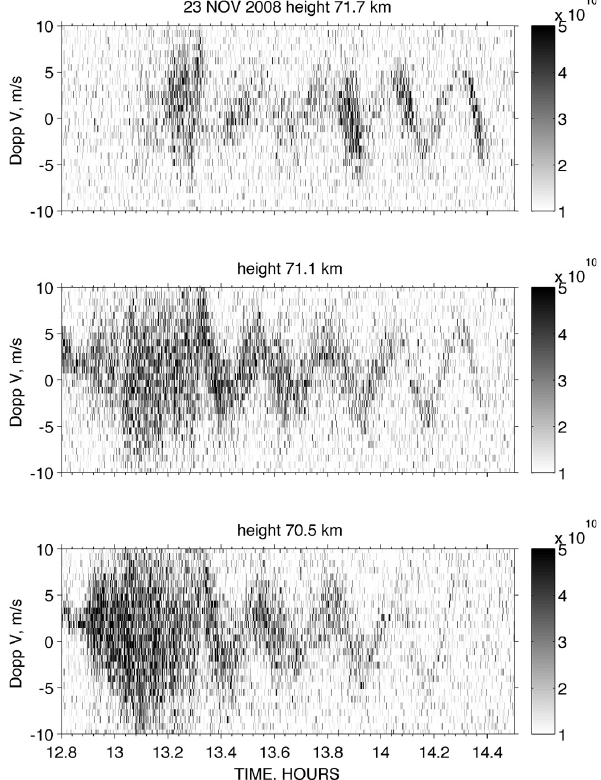
Fig. 2. Dynamical spectra of backscattered power with 4.1s time resolution at three altitudes 70.5km, 71.1km and 71.7km for the experiment on 23 November 2008. The gray scale represents power spectral density of the echo expressed in arbitrary